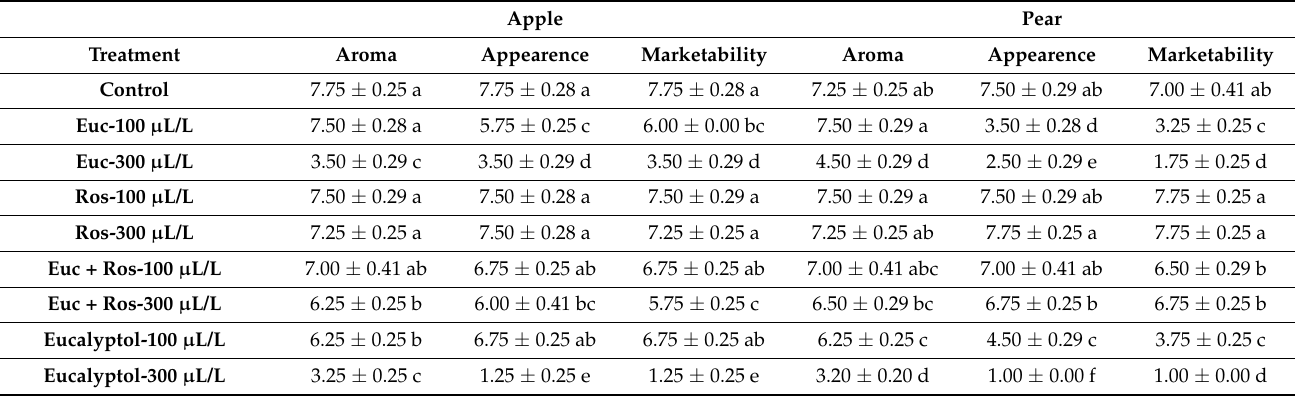
Table 3. Effects of eucalyptus EO (Euc), rosemary EO (Ros), their 50:50 mixture (Euc + Ros) and eucalyptol on marketability (scale 1–10), aroma (scale 1–10) and appearance (scale 1–10) of inoculated with P. expansum apple and pear fruits, stored at 7 ◦ for 8 and 5 days and then transferred at RT for up to 15 and 11 days, respectively. Apple